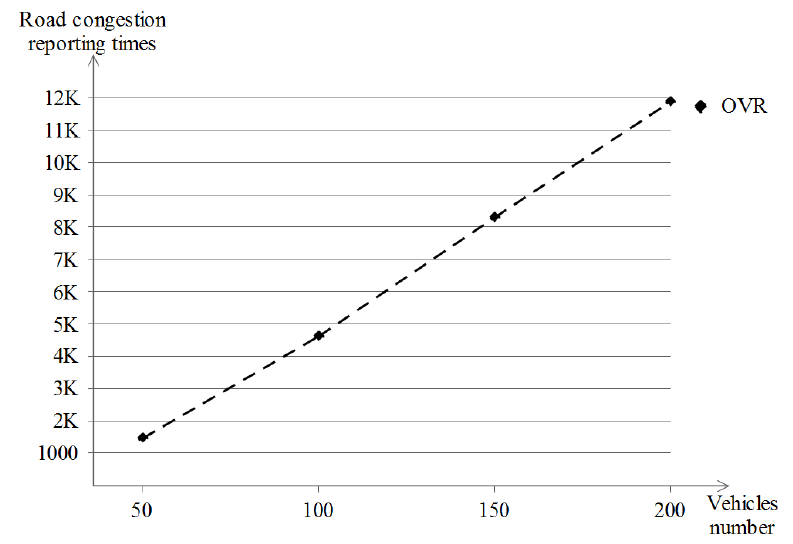
Figure 24. Number of times a road congestion was reported in the Manhattan scenario.